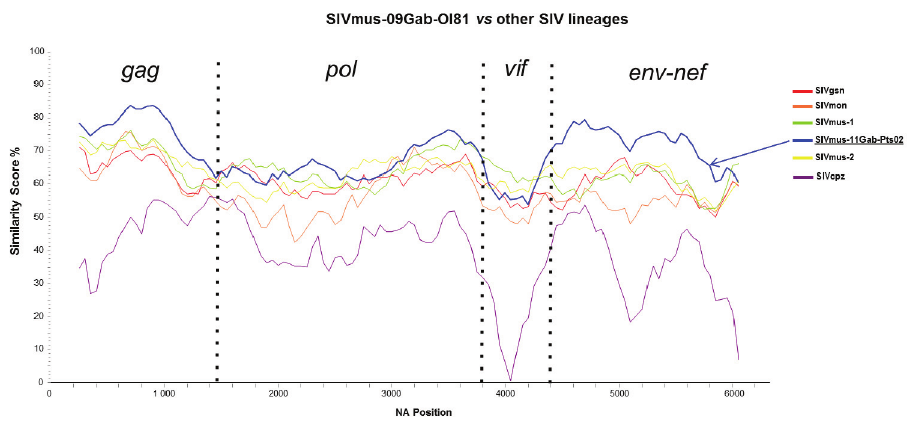
Figure 4. Similarity plots of nucleotide sequences illustrating the extent of genetic diversity between the new SIVmus and other SIV lineages. Similarity plots of gag , pol , vif , env , and nef non-concatenated nucleic acid sequences showing similarities between SIVmus-09Gab-0I81 and SIVmus-11Gab-Pts02 and other SIVs representative for the different SIV lineages (sliding window of 500 na moved in steps of 50 na). Only SIV lineages of interest are retained in the figure for clarity.